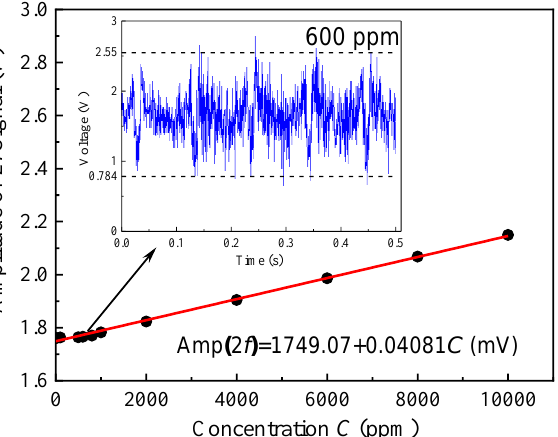
Figure 9. Standard gas tests of the detection system while the methane concentration is 600 ppm.